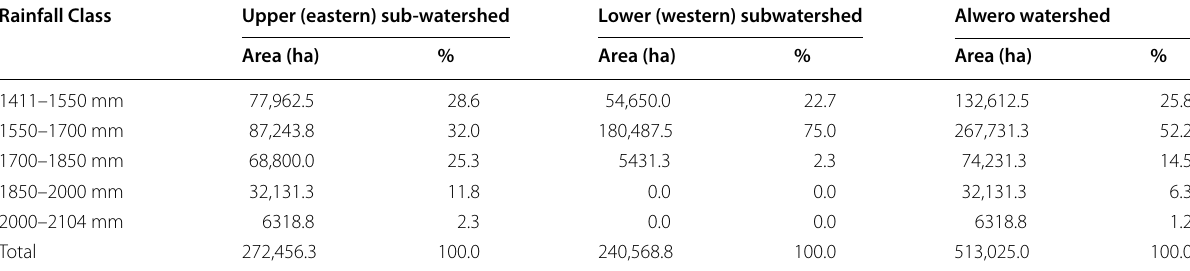
Table 2 Rainfall distribution in Alwero watershed Rainfall Class Upper (eastern)